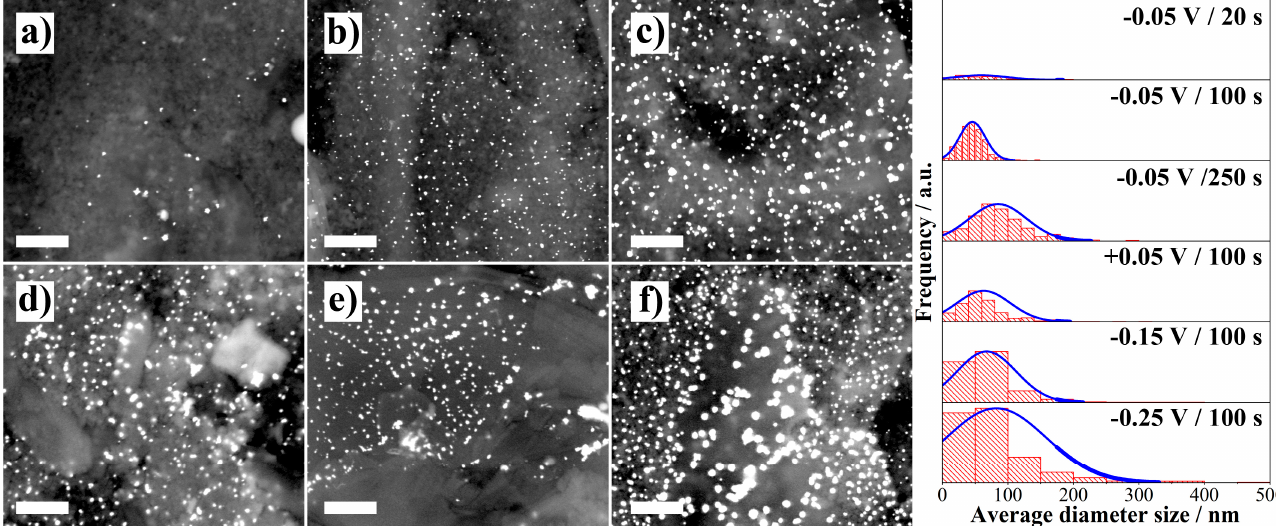
Figure 5. Scanning electron microscopy (SEM) results. Left: Micrographs of the working electrodes with AuNPs prepared by electrodeposition at a constant potential of − 0.05 V during ( a ) 20 s, ( b ) 100 s and ( c ) 250 s, and at a constant time of 100 s at ( d ) +0.05 V, ( e ) − 0.15 V and ( f ) − 0.25 V. All images were recorded with backscattered electron detector (BSED). 50,000 X, scale bar 1 µ m. Right: Histograms of the average diameter size of AuNPs for each